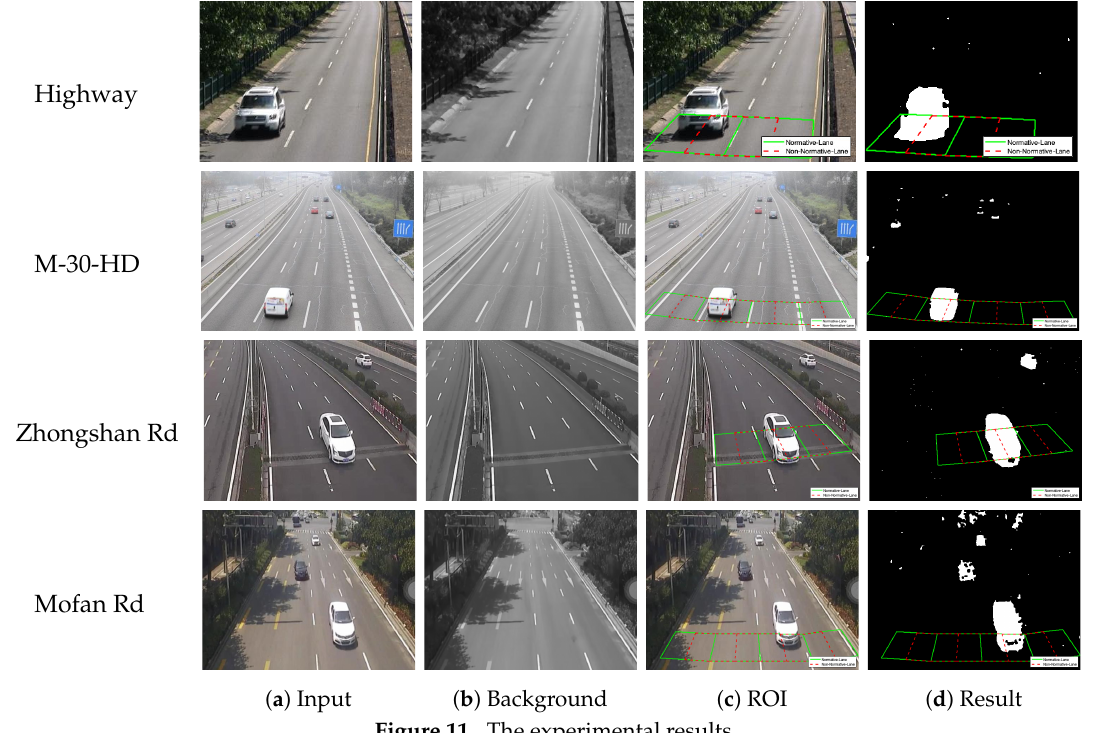
Figure 11. The experimental results. Table 6. The counting results of